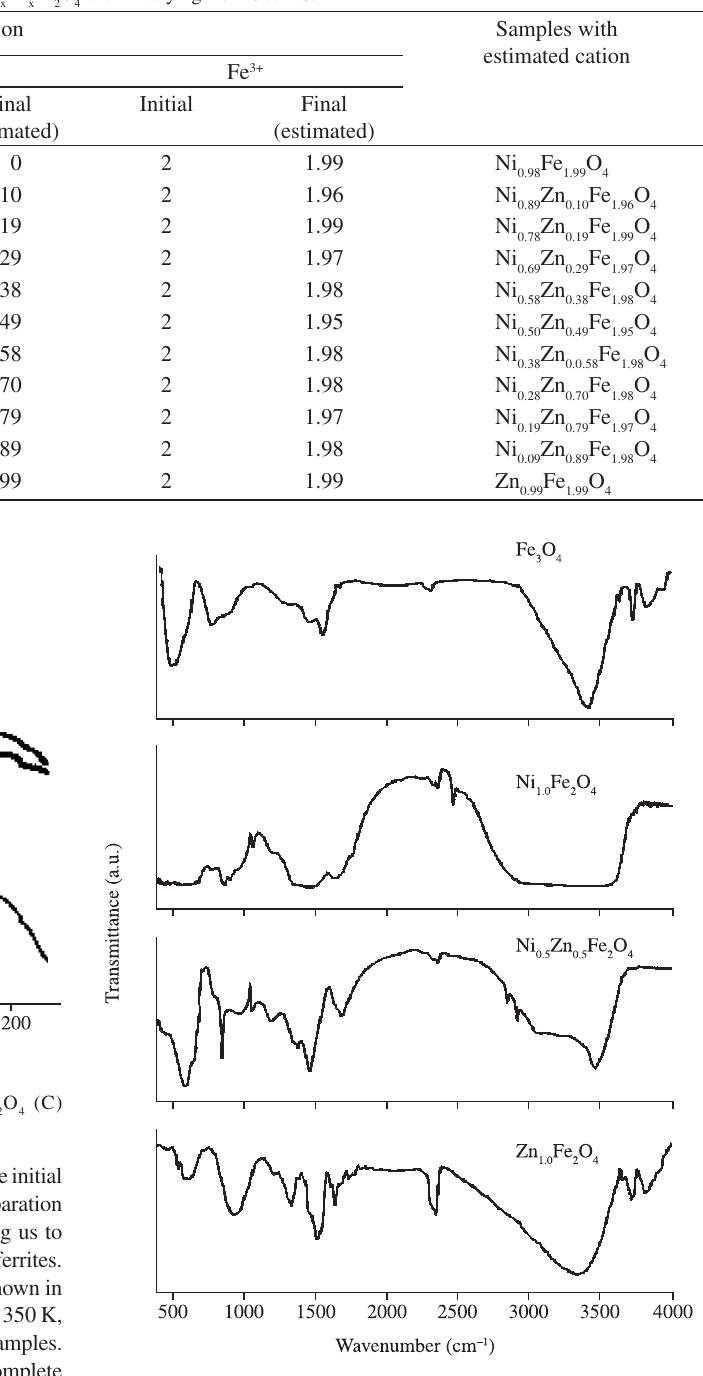
Figure 11. FTIR spectra for Fe x = 0, 0.5 and 1.0.